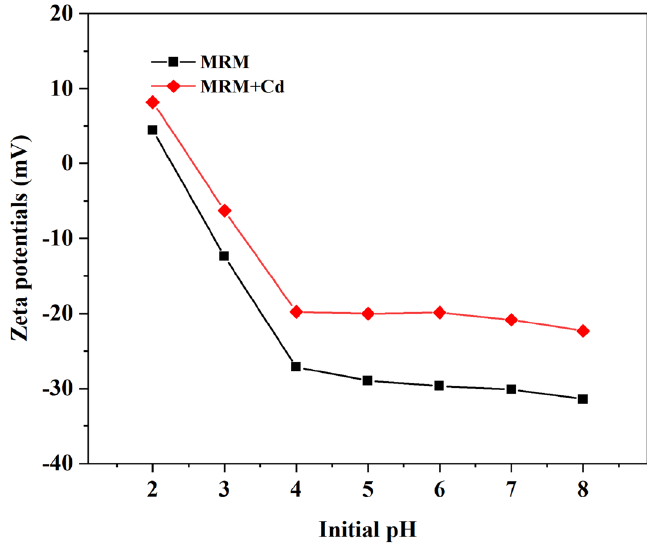
Figure 9. Zeta potentials of MBR and MBR-Cd (II) at various pH values.